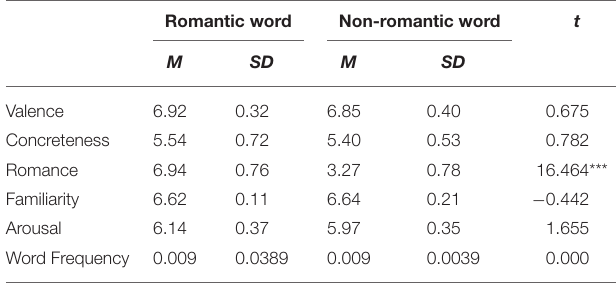
TABLE 1 | Mean ratings of the characteristics of romantic and non-romantic